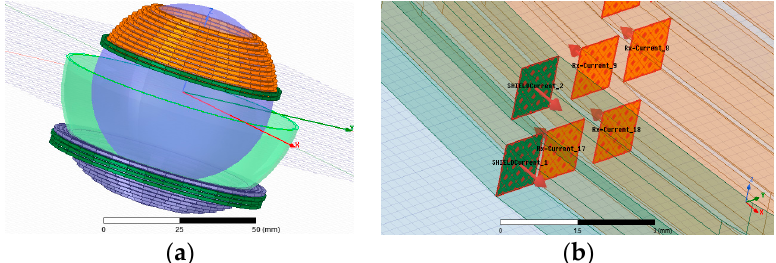
Figure 15. The WPT system: ( a ) shielding coils for Tx and Rx (in green); ( b ) current direction in the shielding turns (in green).